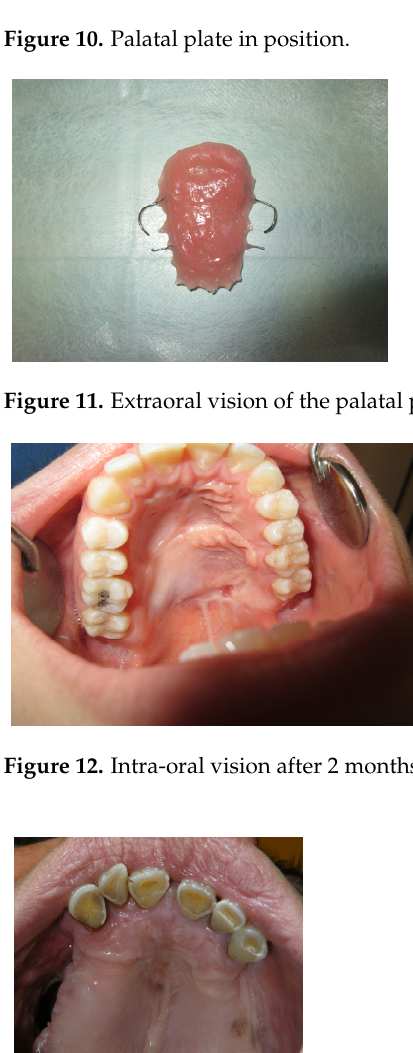
Figure 14. Partial prosthesis in resin with function of palatal plate. Figure 15. After two months.